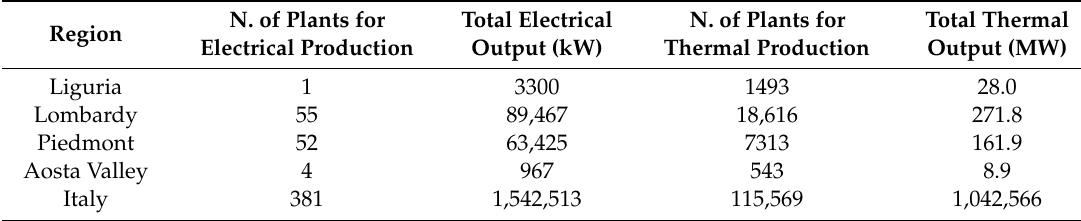
Table 2. Number and power output of solid-biomass-to-energy plants.